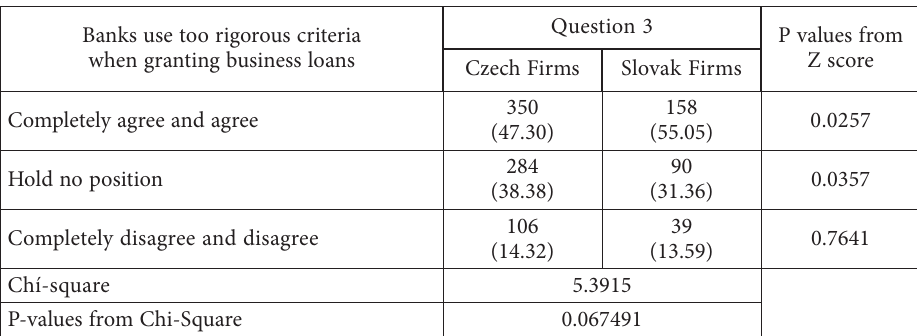
Table 4. Differences in the perception of bank loan obstacles (source: own processing)